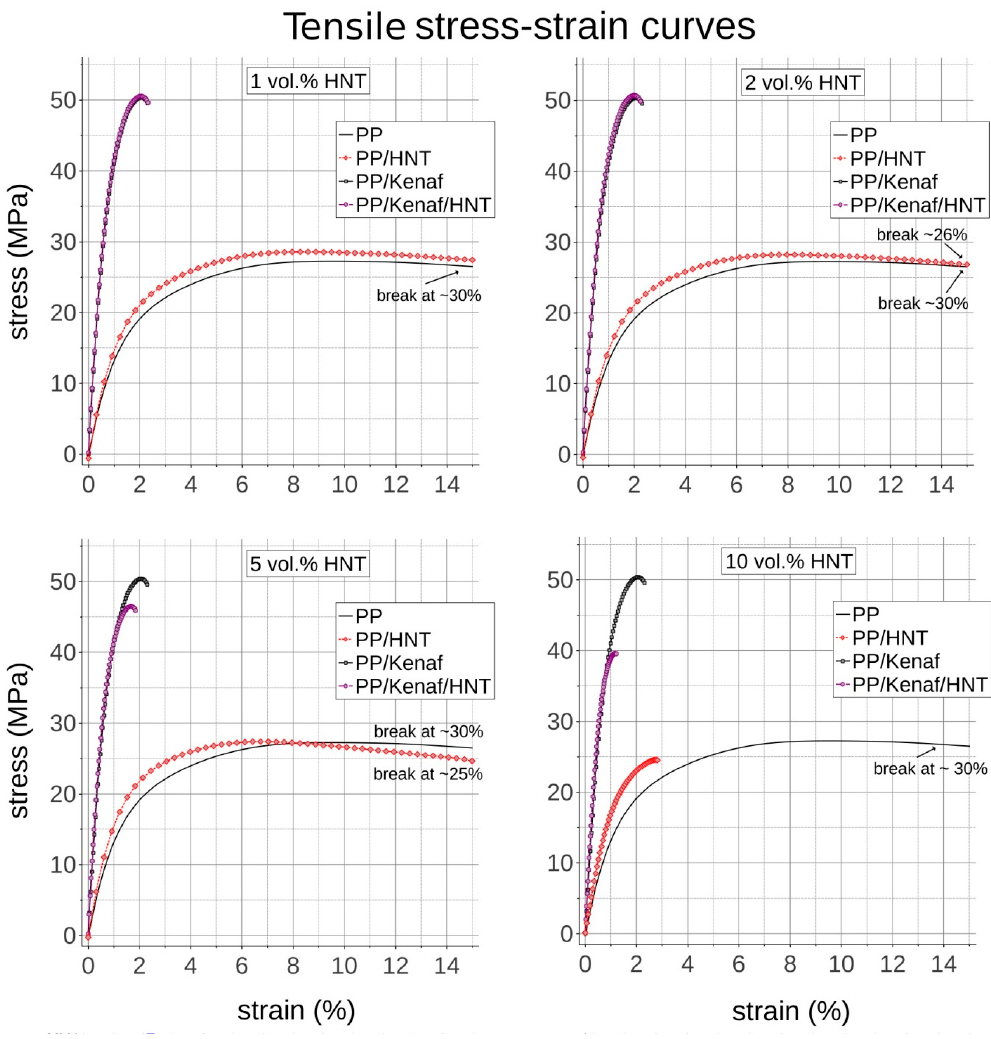
Figure 4. Tensile stress – strain curves for PP, PP/HNT, PP/kenaf, and PP/kenaf/HNT reinforced with different volumetric contents of 1, 2, 5 and 10 vol. % of HNT.